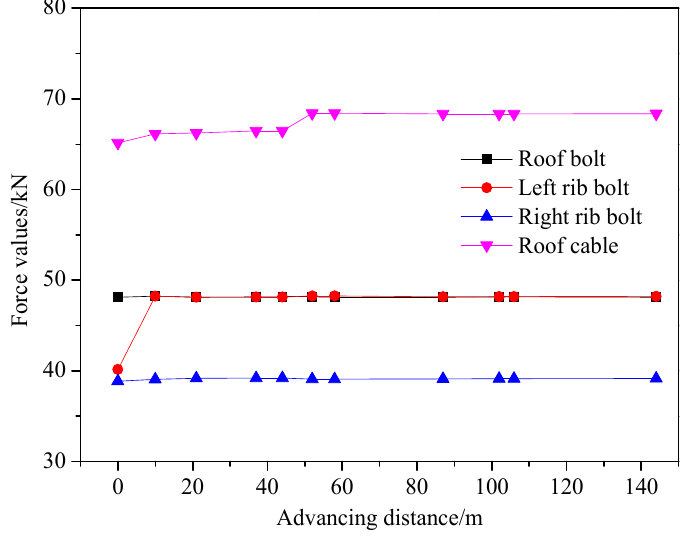
Figure 19. Stress variation of the bolt and cable with the roadway excavation. Table 5. Stress variation of the bolt and cable with the roadway excavation.